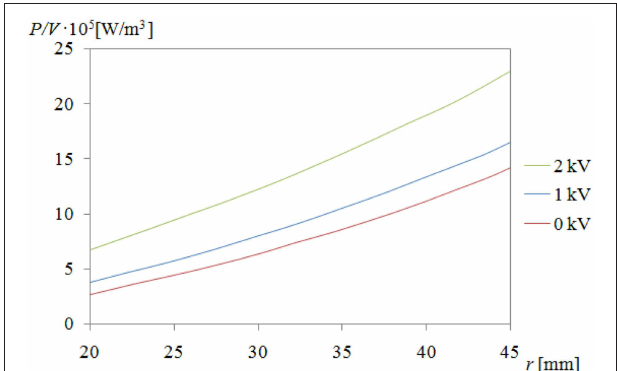
FIGURE 4 | Dependence of P/V from radius r for ω = 100 rad/s and ERF#6 fluid.